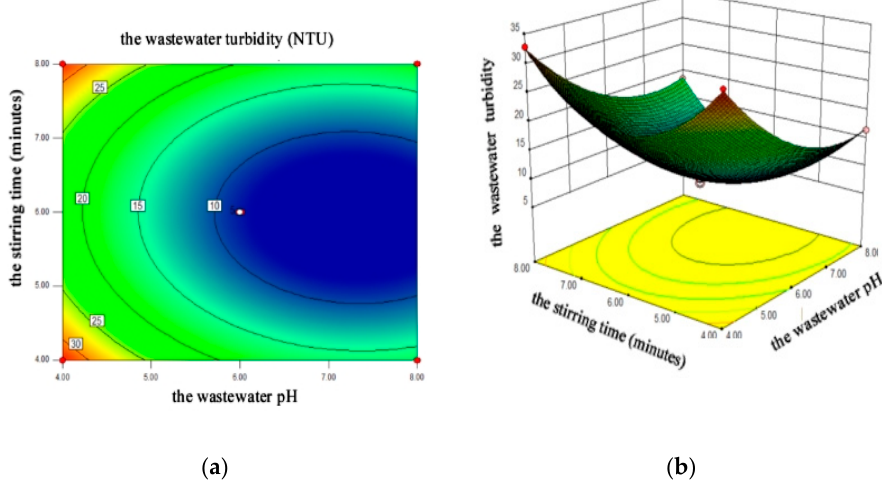
Figure 8. Impact of the interaction between stirring time and wastewater pH on wastewater turbidity. ( a ) Contour diagram; ( b ) 3D surface diagram.